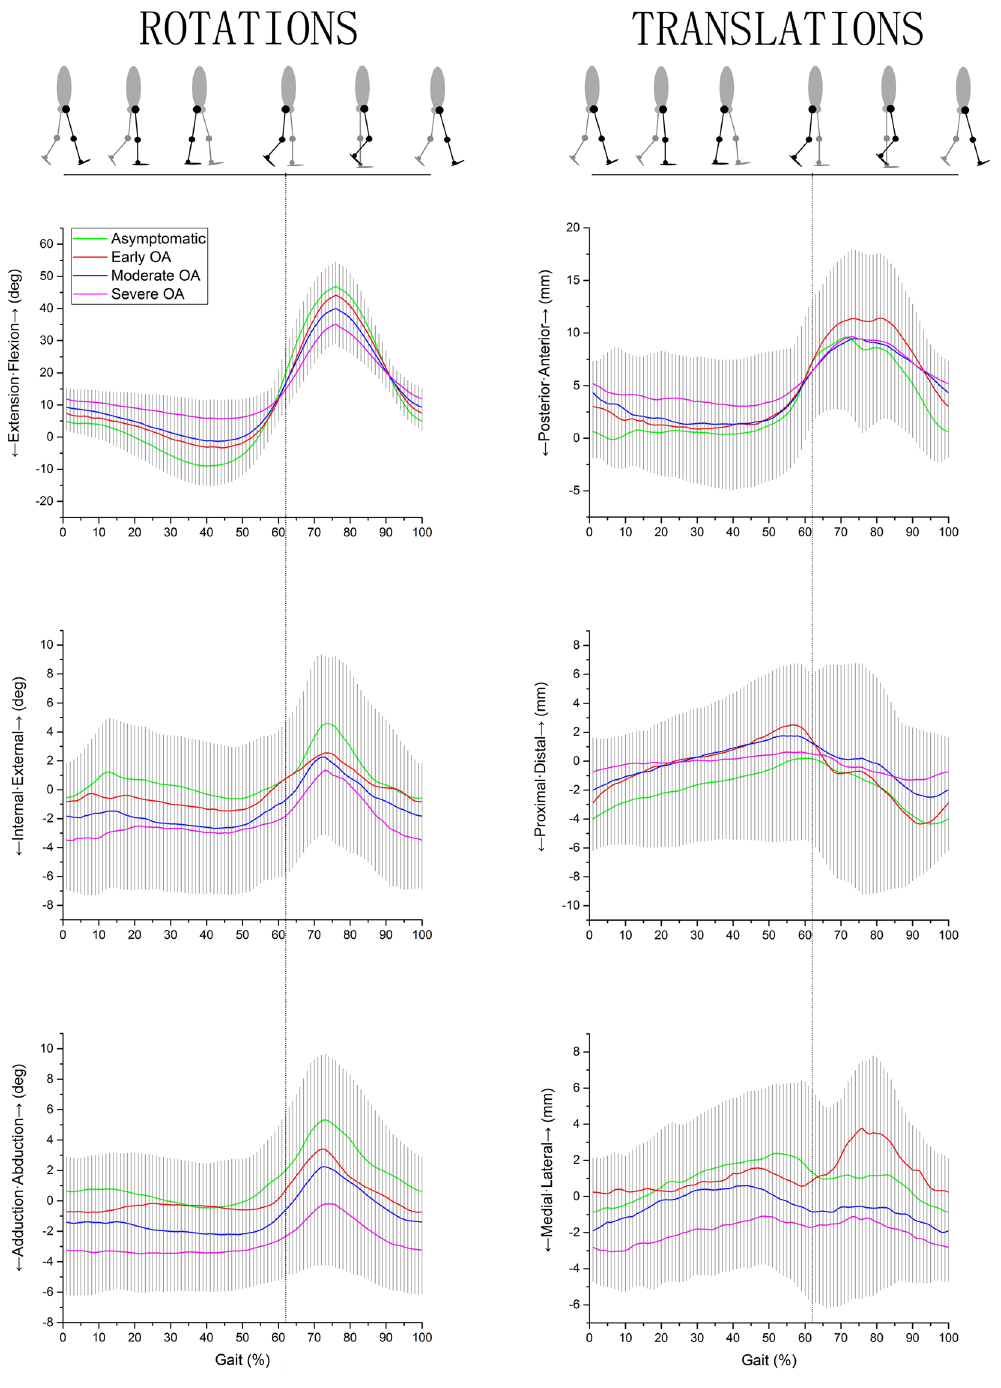
Figure 1. Tibiofemoral kinematics of the subjects in different groups during gait analysis. The thick solid lines represent the participants’ average kinematics of the femur relative to the tibia and the gray shadow area represents the standard deviation of the participants. The green, red, blue and pink lines represent the average motion of the asymptomatic group, early OA group, moderate OA group and severe OA group, respectively. The gait begins with the heel strike and ends with the next heel strike. The gait cycle is divided into a stance phase and a swing phase by toe off (the vertical dashed line, about 62%